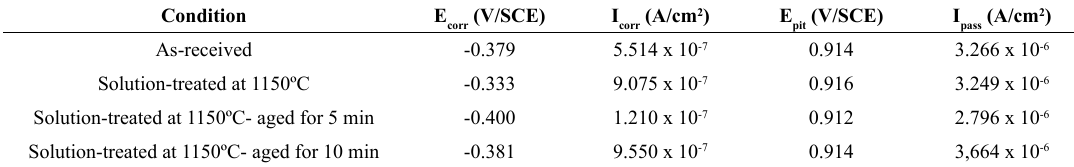
Table 4. Electrochemical parameters of UNS S32520 SDSS obtained in 3.5 % NaCl solution at 25ºC Condition